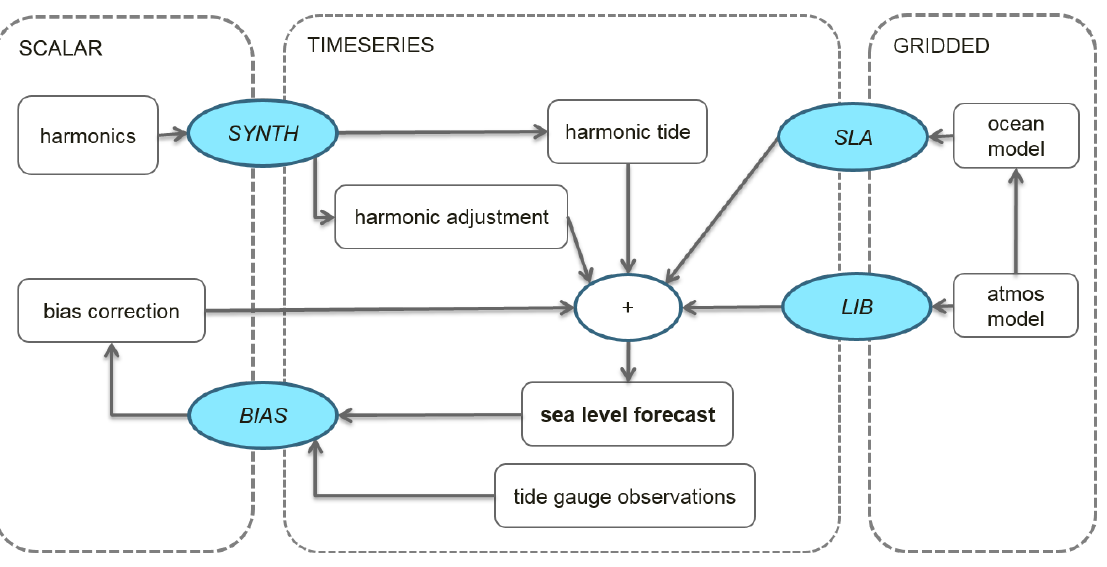
Figure 2. Schematic illustration of aggregation configuration. Source systems are heterogeneous but mapped onto time series that can be directly compared against 1-hourly observations. ( SYNTH ) indicates tidal synthesis, ( SLA ) sea level anomaly from OceanMAPS, ( LIB ) local inverse barometer approximation based on atmospheric pressure forecast, ( BIAS ) non-causal filter bias correction